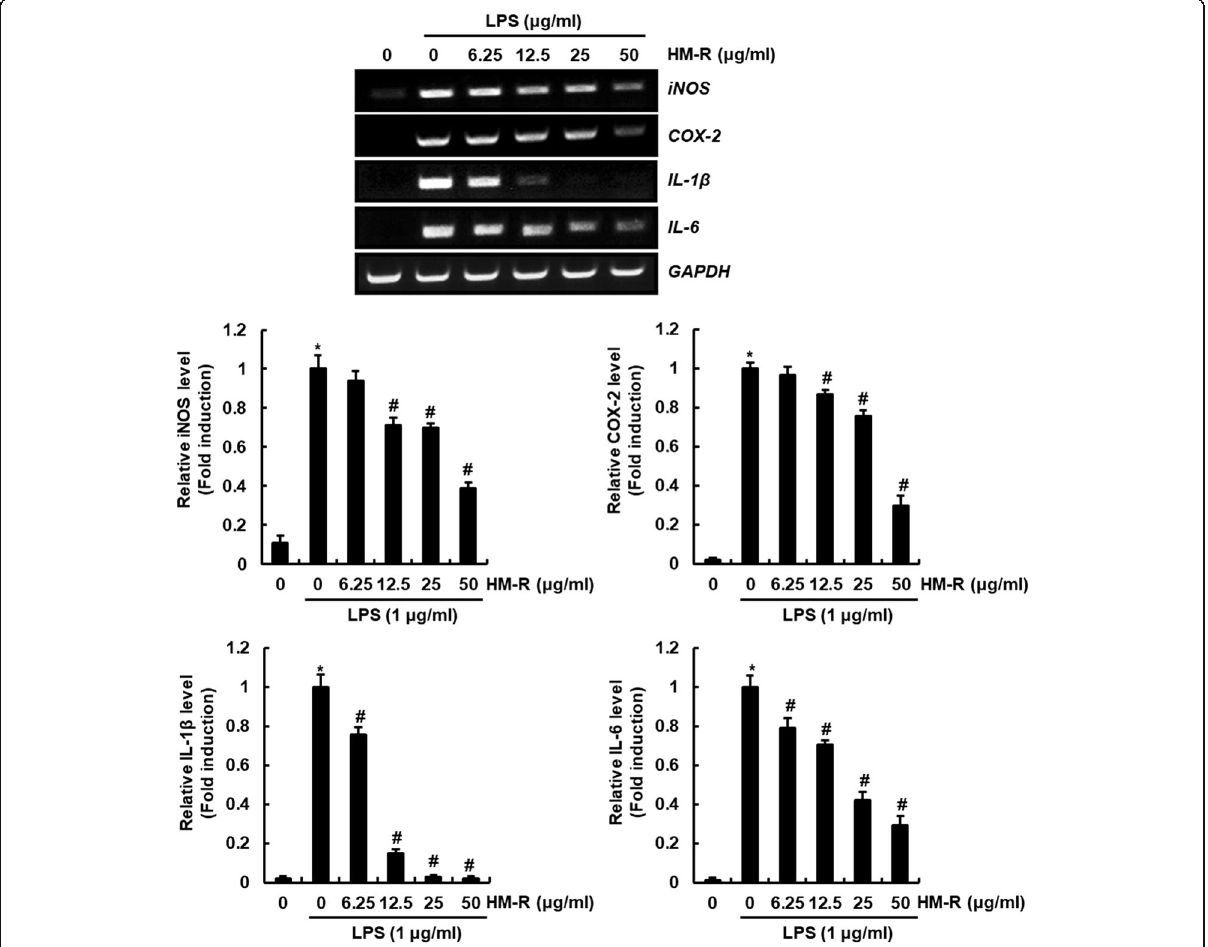
Fig. 2 Inhibitory effect of HM-R against iNOS, COX-2, IL-1 β and IL-6 in LPS-stimulated RAW264.7 cells. RAW264.7 cells were pretreated with HM-R for 2 h and then co-treated with LPS (1 μ g/ml) for 18 h. Total RNA was prepared after LPS and HM-R treatment. GAPDH was used as internal control for RT-PCR. The density of mRNA bands was calculated using the software UN-SCAN-IT gel version 5.1 (Silk Scientific Inc. Orem, UT, USA). *P < 0.05 compared to the cells without the treatment, and # P < 0.05 compared to the cells treated with LPS